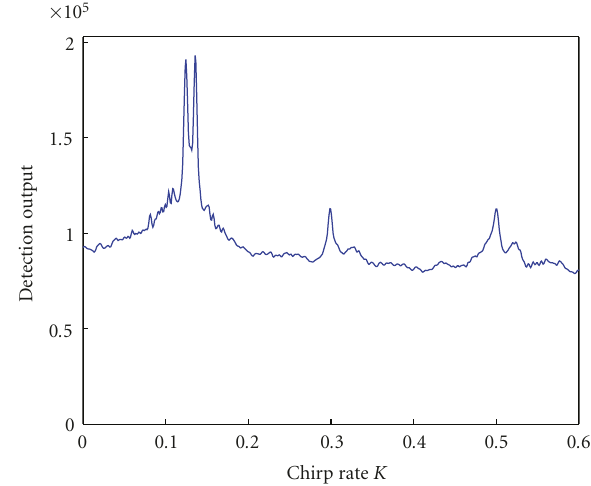
Figure 4: The detection output of multicomponent LFM-signal with SNR = − 6dB using the 3rd-power modulus form.